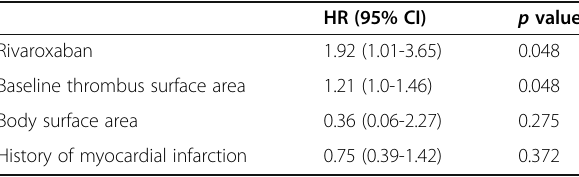
Table 2 Multivariable analysis of predictors of left ventricular thrombus resolution